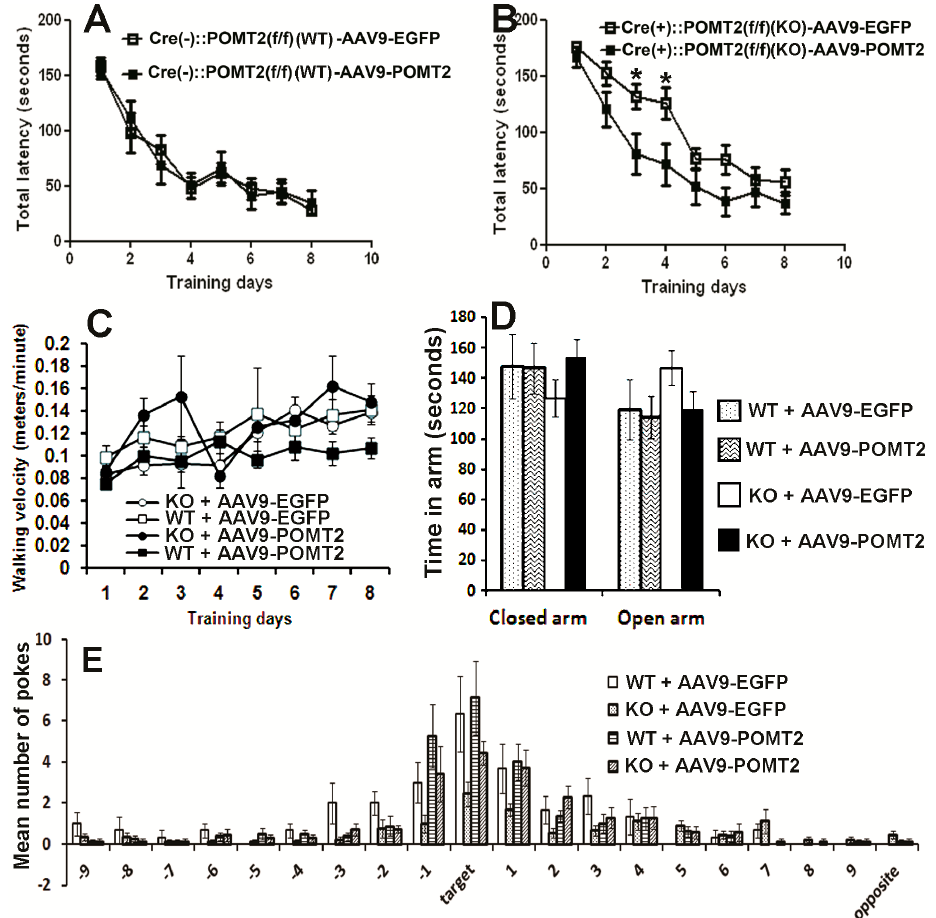
Figure 6. Learning deficits in cerebral cortex-specific POMT2 knockout mice are rescued by AAV9-POMT2-treatment. AAV9-EGFP- and AAV9-POMT2-treated mice were analyzed using the Barnes maze and the elevated plus maze at three to five months of age. ( A ) Wildtype animals exhibited similar latency to the target hole with ( n = 13) or without ( n = 11) AAV9-POMT2 treatment, indicating that AAV9-POMT2 treatment did not change spatial learning in wildtype animals. ( B ) Compared to AAV9-EGFP-treated knockout mice ( n = 16), AAV9-POMT2-treated knockout mice ( n = 10) showed decreased latency to the target hole ( p = 0.0226, repeated measures ANOVA). Asterisks: p < 0.05, post-hoc Bonferroni comparisons test. ( C ) Walking velocity on the Barnes maze platform was not significantly different amongst different groups. ( D ) Time spent in the open and closed arms of the elevated plus maze was not significantly different in AAV9-POMT2-treated animals, indicating that there was not a change in anxiety levels after gene therapy. ( E ) The probe trial showed that AAV9-EGFP-treated knockout mice visited the target hole and the two holes adjacent to the target hole fewer times than AAV9-EGFP-treated wildtype mice. AAV9-POMT2-treatment increased the knockout mice’s number of visit to these holes compared to the AAV9-EGFP-treatment. Abbreviations: KO, wildtype; WT, wildtype.